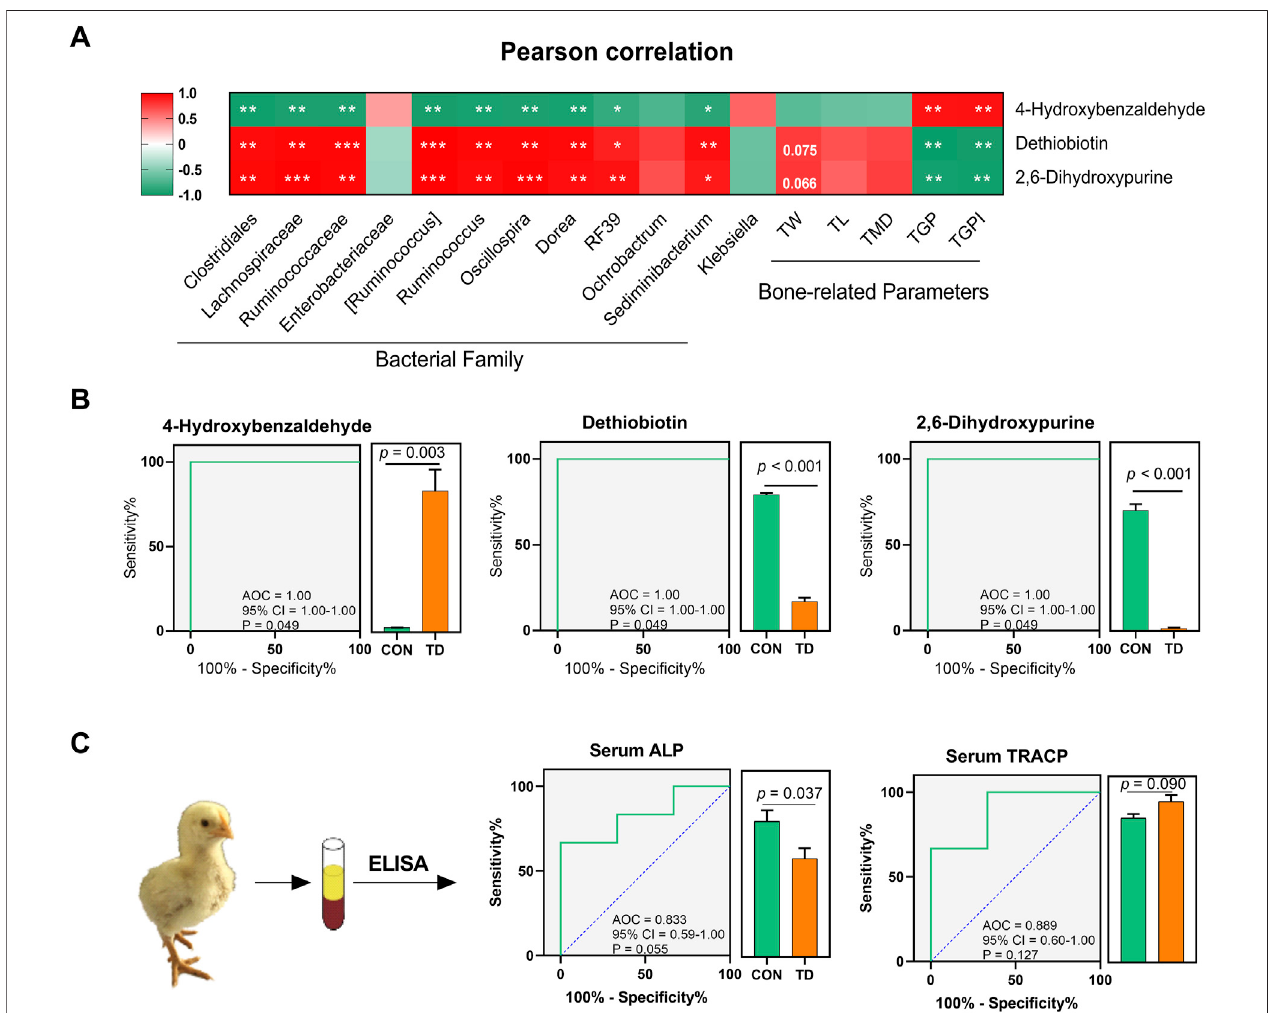
FIGURE 7 | Fecal metabolite biomarkers for the diagnosis of TD broiler chickens. (A) Pearson correlation analysis between the differential microbiota and metabolites, differential metabolites and tibia-related parameters in feces of broiler chickens with TD. The asterisks indicate statistically signi fi cant differences and correspond to p < 0.05 (*), p < 0.01 (**), and p < 0.001 (***). A p -value higher than 0.05 ( > 0.05) represents statistically non-signi fi cant (N = 4). (B) Curves of ROC of differentialmetabolitebiomarkersfordiagnosisofTDinanindependenttestset.AnAUCcloseto1.0indicateshighsensitivityandspeci fi cityandstatisticalanalysis wasperformedontherelativeabundancesofthethreedifferentialmetabolitesbetweengroupsbytheStudent ’ s t -test, a p -value < 0.05wasconsidered tobesigni fi cant (N = 4). (C) ROC curve of serum ALP and TRACP for diagnosis of TD (N = 3).